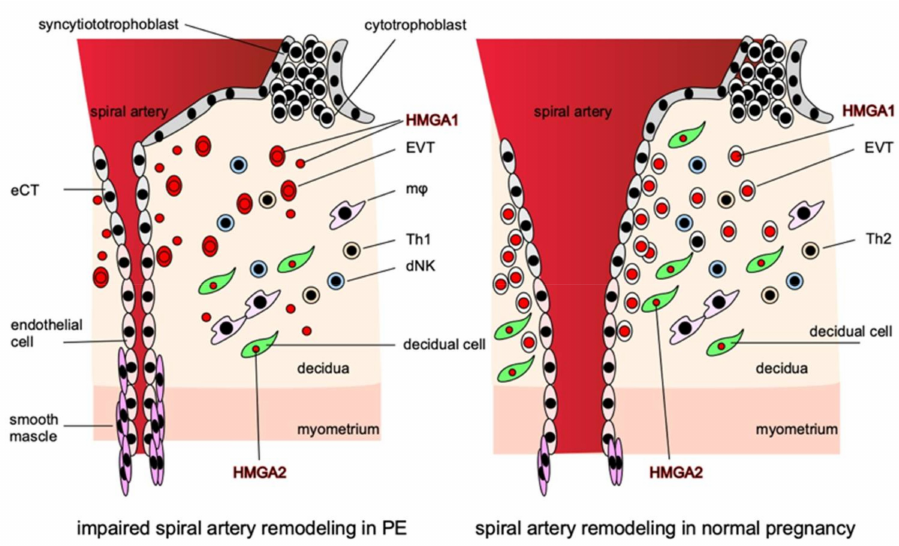
Figure 2. HMGAs are involved in the pathogenesis of PE. HMGA1 is localized in the nuclei of EVTs and is involved in their proliferation and invasion, while in PE, HMGA1 is released from the nuclei of EVTs into the cytoplasm and extracellular space from early pregnancy and impairs EVTs proliferation and invasion. HMGA2 is localized in the nuclei of decidual cells and, together with HMGA1, creates an appropriate microenvironment that promotes the proper invasion of EVTs at the site of implantation. In the disturbance of proper EVTs invasion, the remodeling of the spiral arteries is disturbed, resulting in narrow vessels, and the perivascular smooth muscle cannot supply sufficient blood to the placenta by constricting the vessels, thus inhibiting